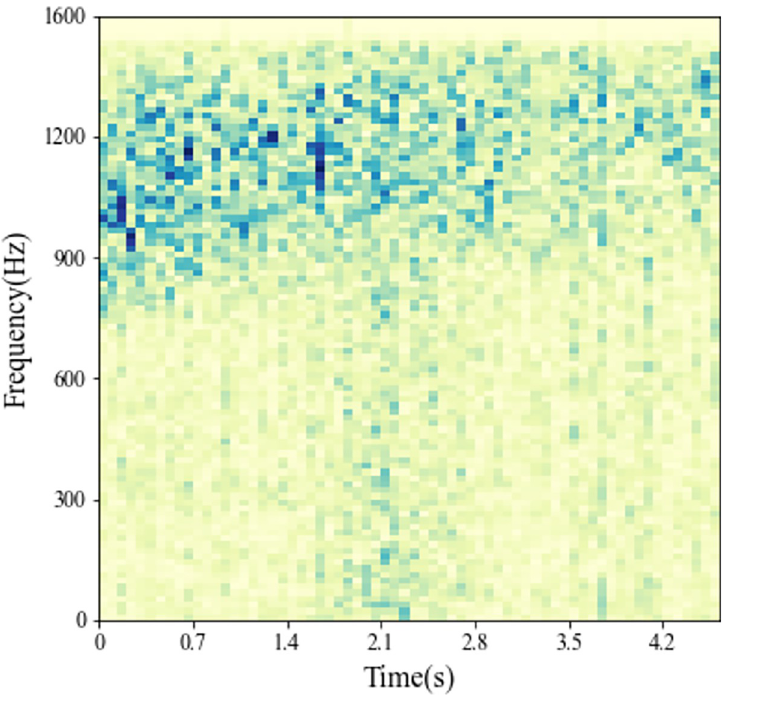
Fig 22. Multi-beam LOFAR spectrogram of the target.